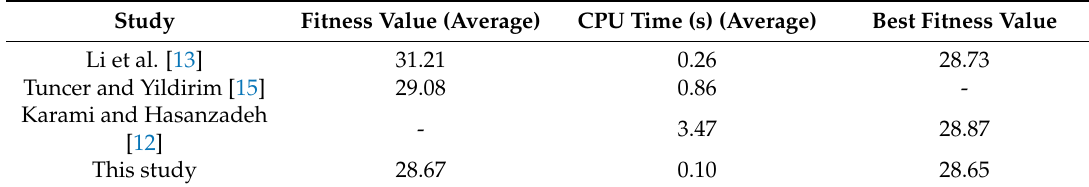
Table 1. Comparison of results in Environment 1.